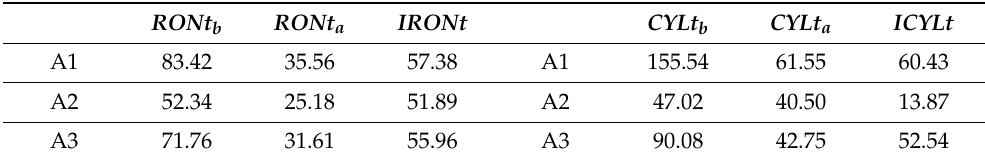
Table A1. Measured roundness total ( RONt ) and cylindricity ( CYLt ) for test specimens and calculated improvement ratios IRONt , ICYLt ,